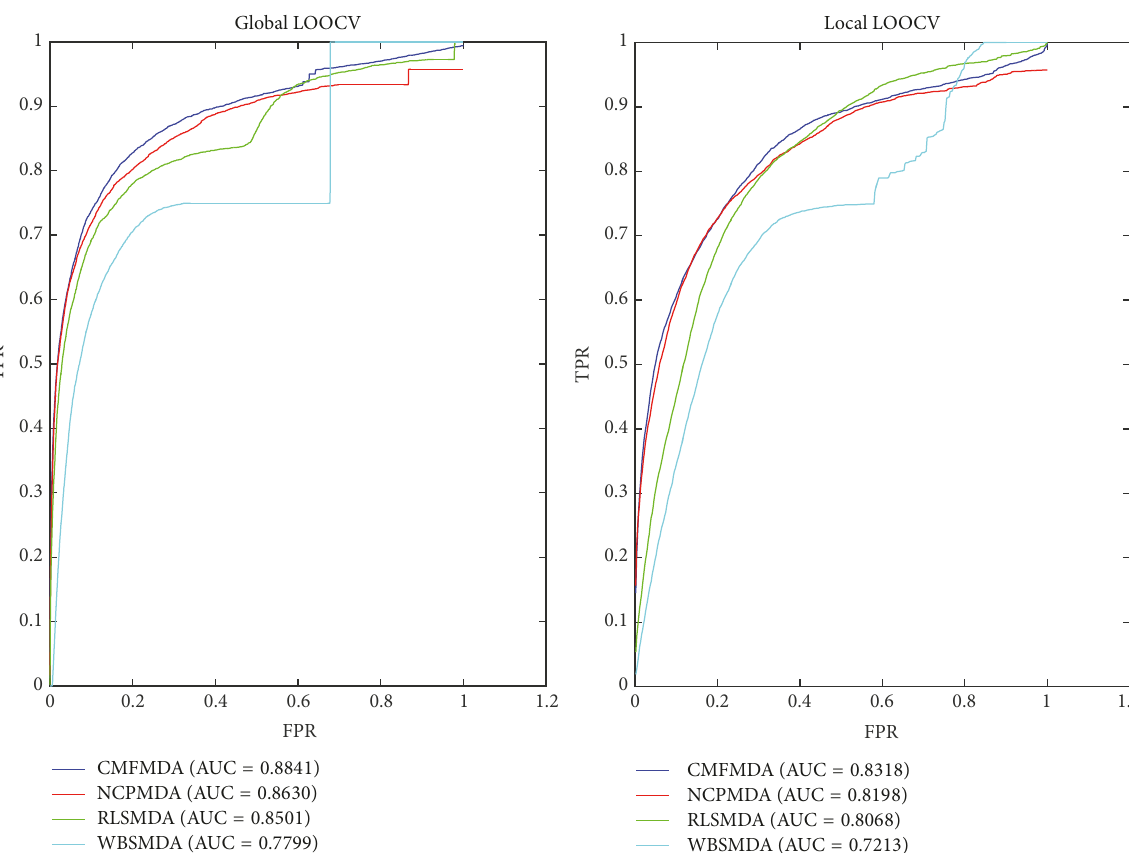
clear cell RCC (CCRCC), and papillary RCC (PRCC).